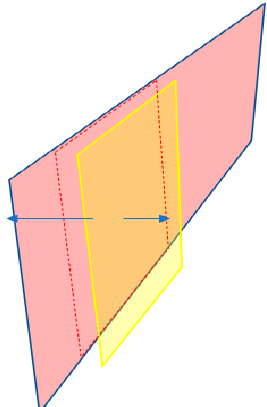
Figure 11. 3D schema of projection of face’s polygon onto the target plane. Table 4. Pseudo code for select the faces to intersect with the target face. Pseudo Code